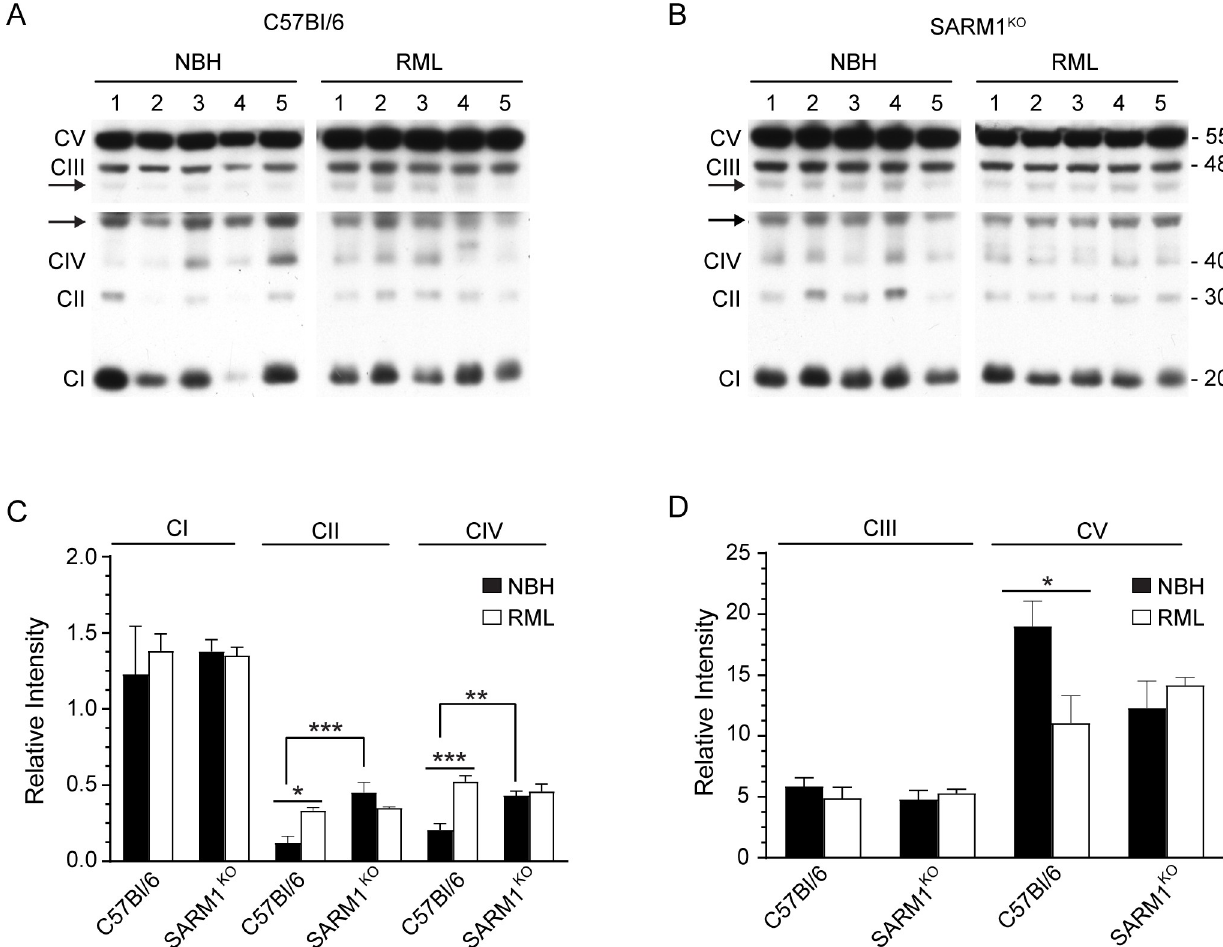
Fig 9. Altered expression levels of mitochondrial complex proteins in prion infected mice. (A) Expression level of mitochondrial complexes CI-CV in C57Bl/6 mice inoculated with NBH or RML prions. (B) Expression of mitochondrial complexes CI-CV in SARM1 KO mice inoculated with NBH or RML prions. For both A and B, blots were developed using the Total OXPHOS Rodent WB Antibody Cocktail and an antibody to β -actin. The upper and lower panels are different exposures of the same blot, with the 45 kDa β -actin band indicated by the black arrows on the left side of the panel. Numbers above each lane represent individual mice. The molecular mass in kDa of the proteins detected in CI-CV is indicated on the right side of Panel B. Quantitation of (C) expression levels of CI, CII, and CIV and (D) expression levels of CIII and CV. Data were normalized to mouse β -actin (Relative Intensity) and were calculated from n = 5 animals for each condition. Black bars = NBH inoculated, open bars = RML prion inoculated. Mean ± SEM is shown. Significance was calculated using a 1-way ANOVA multiple comparisons test with NBH inoculated C57Bl/6 mice set as the control. � p = 0.01–0.03; �� p = 0.003; ��� p =